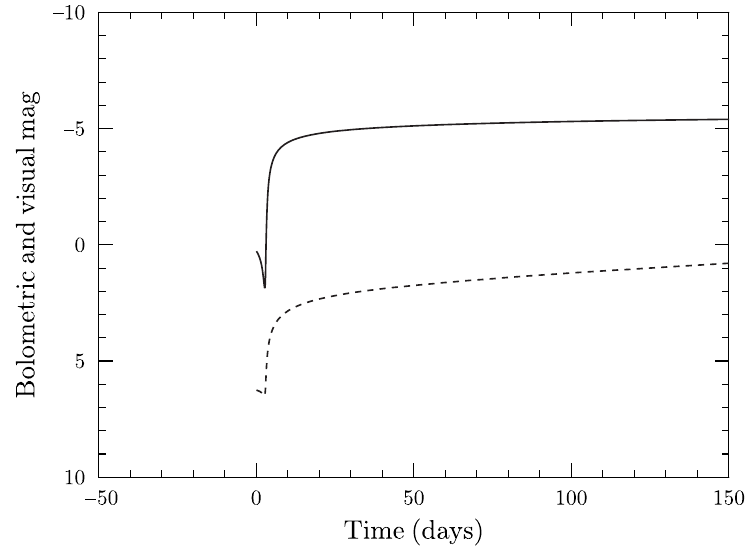
Fig. 8. The same as in Figure 7 but for 0.7 M ⊙